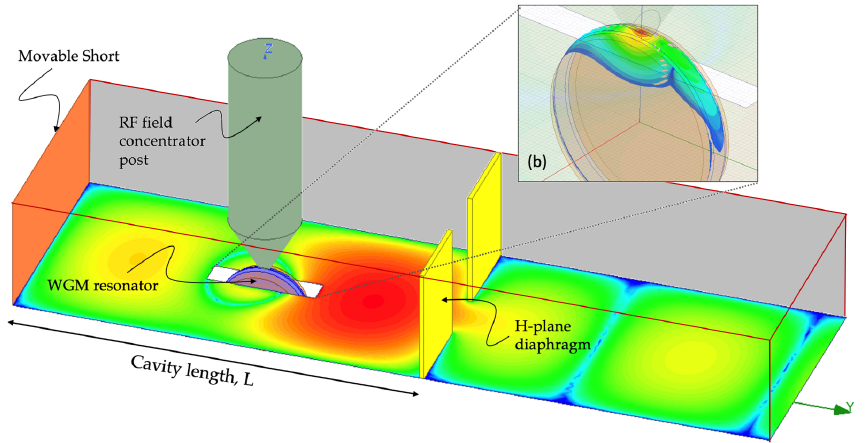
Figure 4. Structural model of the resonant section of the electro-optical transducer in HFSS with the WGM resonator and RF-field concentrator post. The wave-port excitation is to the right of the structure and the movable short is modeled as a PEC to the left. The H-plane diaphragm (also modeled as PEC plates) and the movable short create the waveguide cavity, parameterized by its length L. The strength of simulated E-field inside the waveguide structure is shown with the scaled colormap (red corresponding to the strongest field strength). Inset (b) shows the distribution of the simulated field inside the